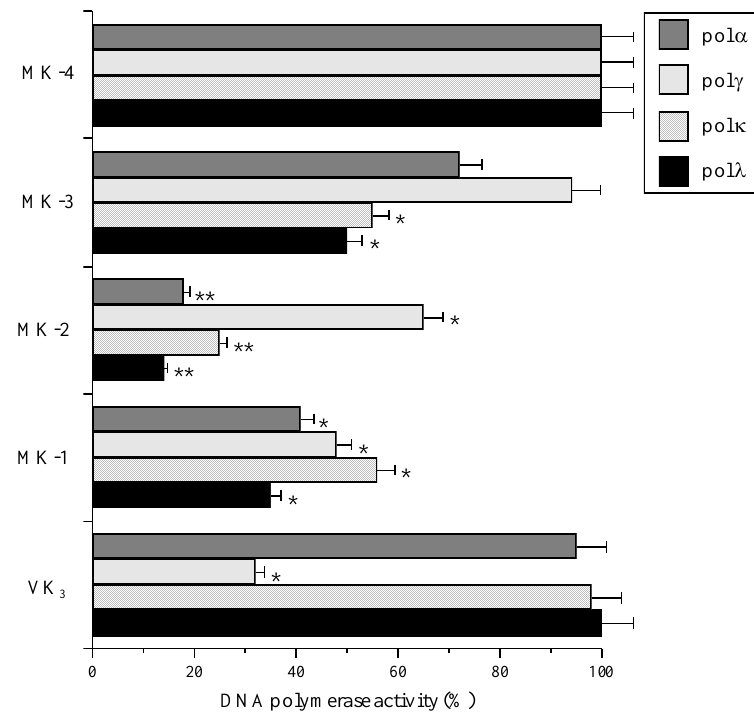
Figure 2. Inhibitory effects of the VK and VK intermediates on the activity of 2 3 mammalian pols. Each compound (50 κM) was incubated with calf pol α (B-family pol), human pol γ (A-family pol), human pol θ (Y-family pol) and human pol ι (X-family pol) (0.05 units each). Pol activity in the absence of the compound was taken as 100%, and the relative activity is shown. Data are shown as the mean ± SE ( n = 3). ** P < 0.01 and * P < 0.05 versus